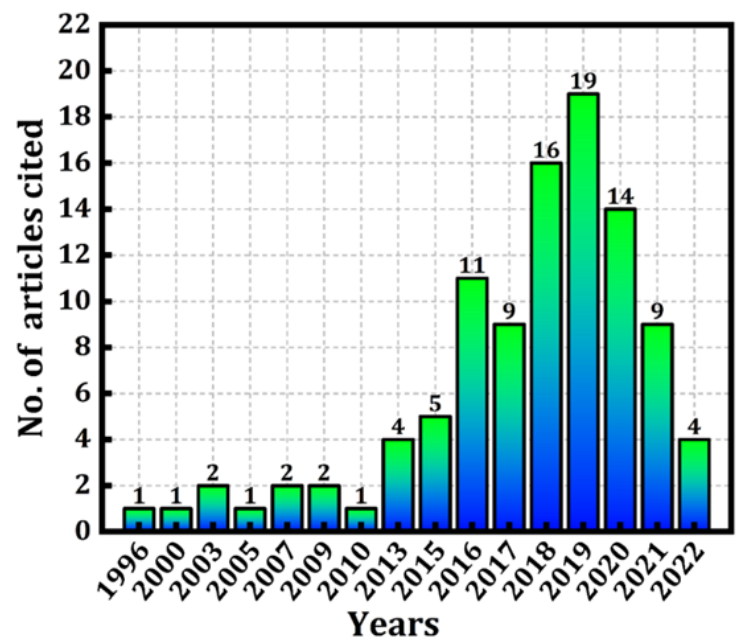
Figure 1. A number of articles cited between 1996 and 2022.